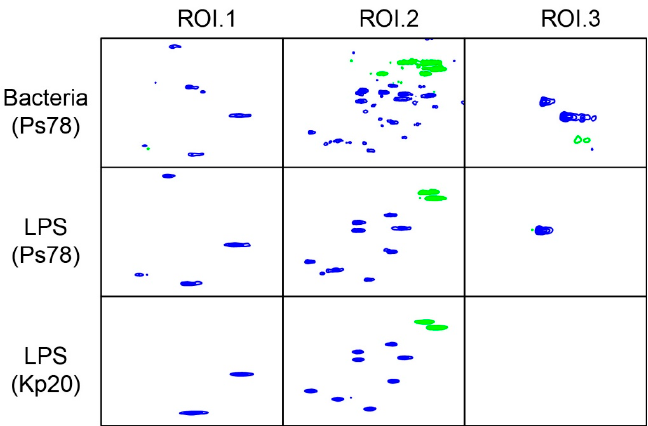
Figure 1. Regions of interest (ROI) extracted from the high-resolution magic angle spinning (HR-MAS) HSQC-DEPT NMR spectra of the O- antigens of P. shigelloides strain CNCTC 78/89 (Ps78) bacteria and LPS compared to these of K. pneumoniae strain Kp20 LPS. The regions were selected directly from the SPARKY processed spectra using the rNMR software. The compared regions and their chemical shift ranges include: anomeric signals (ROI.1, δ H 5.45–4.96 ppm, δ C 112.6–79.5 ppm), the ring resonances